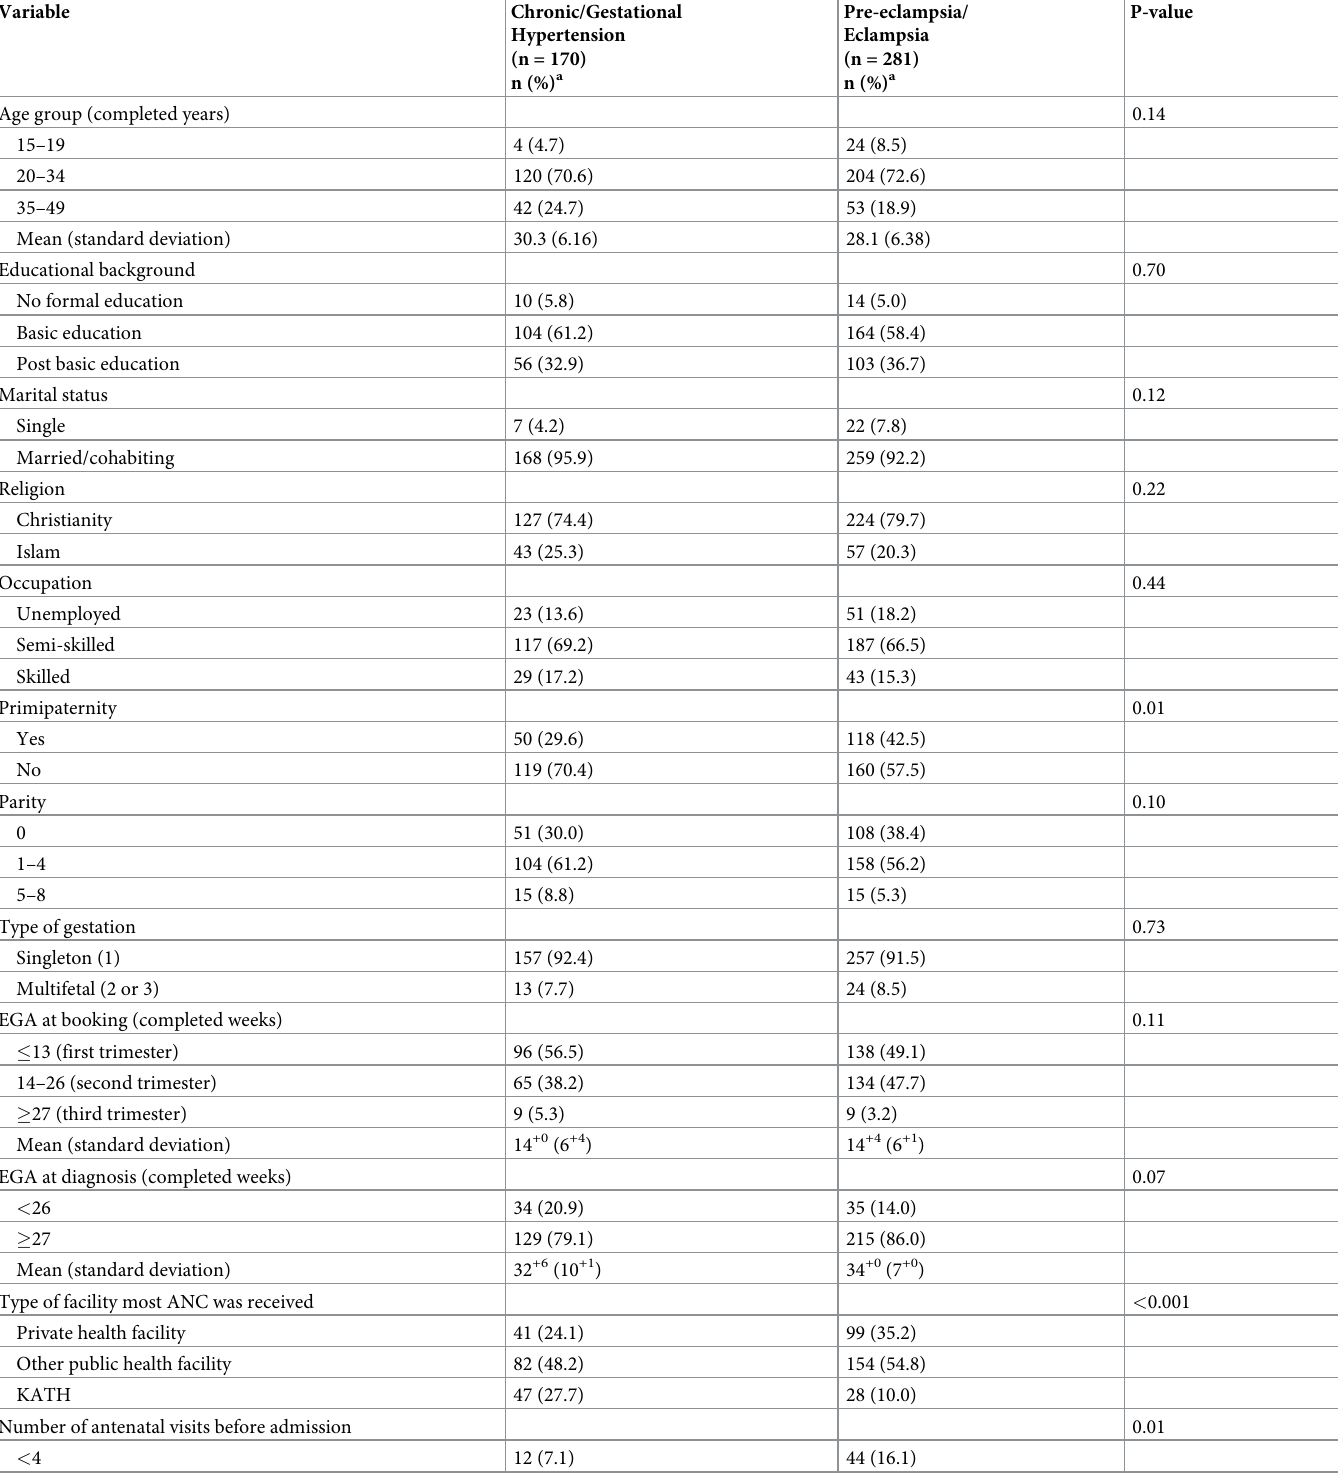
Table 1. Comparison of socio-demographic and reproductive characteristics among women with chronic/gestational hypertension and those with pre-eclampsia/